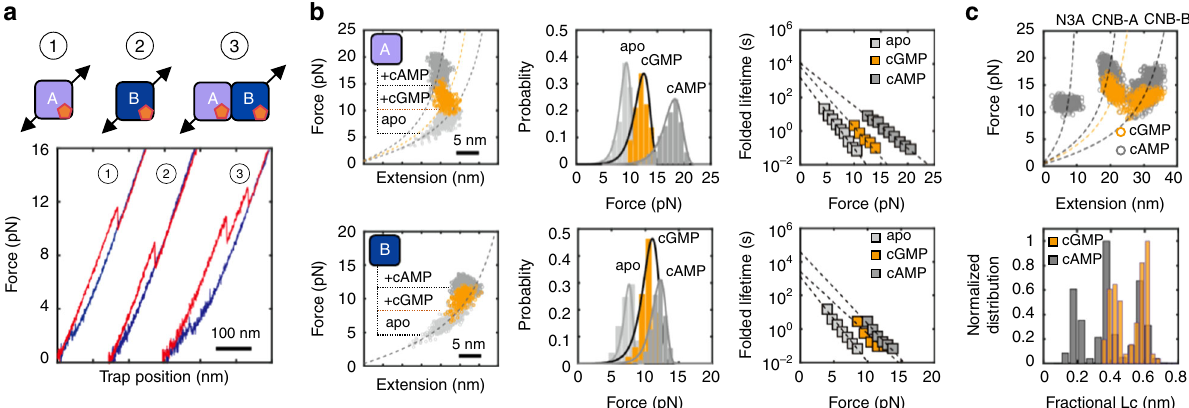
Fig. 7 Perturbation of allosteric networks in PKA by cGMP. a Force-extension curves of cGMP-bound protein constructs. b WLC analysis of changes in extension upon unfolding vs. force (left), unfolding force probability distributions (center) and force-dependent folded-state lifetimes (right) for the isolated CNB-A (top) and CNB-B (bottom) domains in the apo (light gray), cGMP-bound (orange), and cAMP-bound (dark gray) states. Solid lines in center panels are the unfolding force distribution reconstructed from force-dependent lifetimes. c WLC analysis of changes in extension upon unfolding vs. force (top) and fractional contour length (bottom) of the regulatory subunit bound to cGMP (orange) and cAMP (gray). Dashed lines are the WLC curves for the N3A motif and the two CNB domains with cAMP (gray) and cGMP (orange). Source data are provided as a Source Data fi